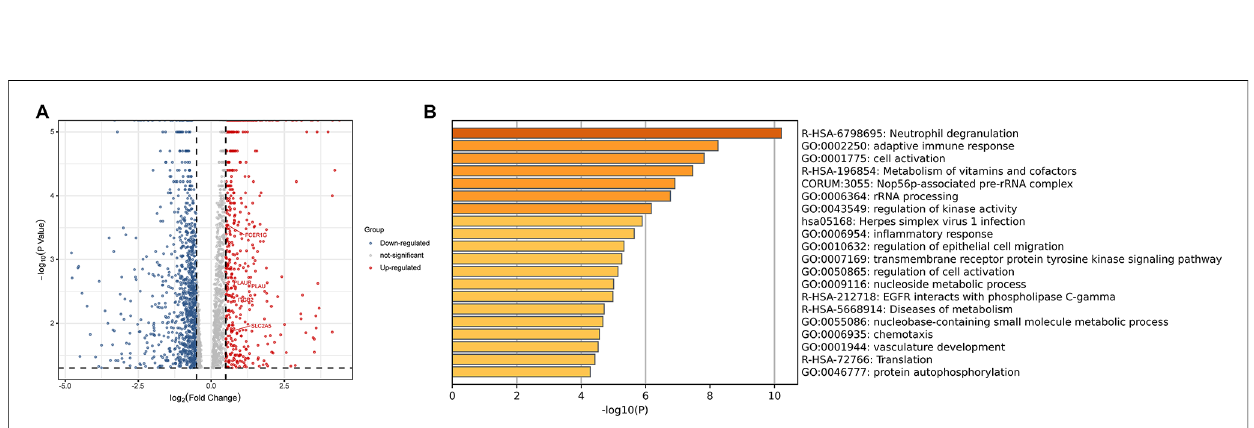
FIGURE 8 ( A ) The volcanic plot of gene expression pro fi ling of patients with plaque rupture. ( B ) Functional enrichment analysis of DEGs. DEGs, Differential Expression